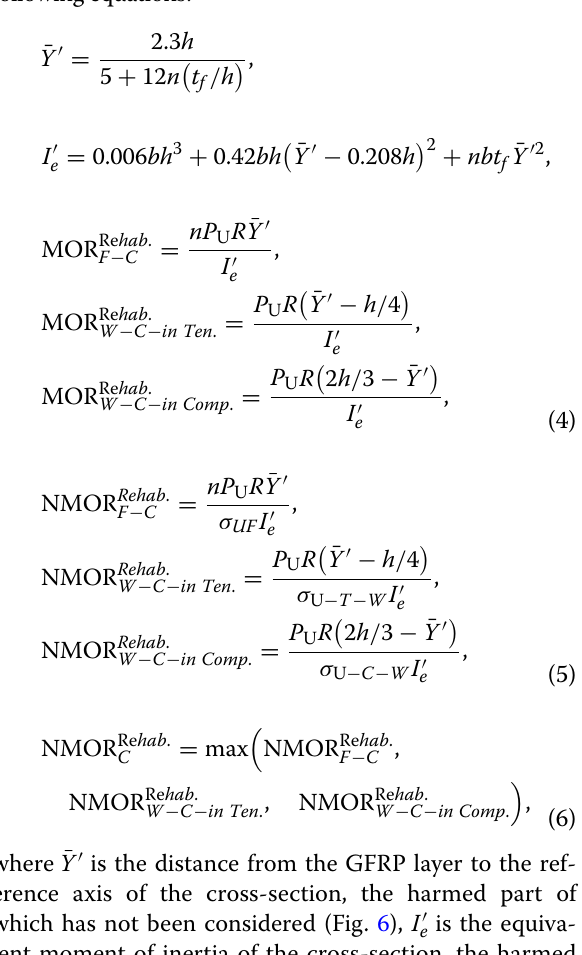
Fig. 6 The rehabilitated cross‑section used for calculating